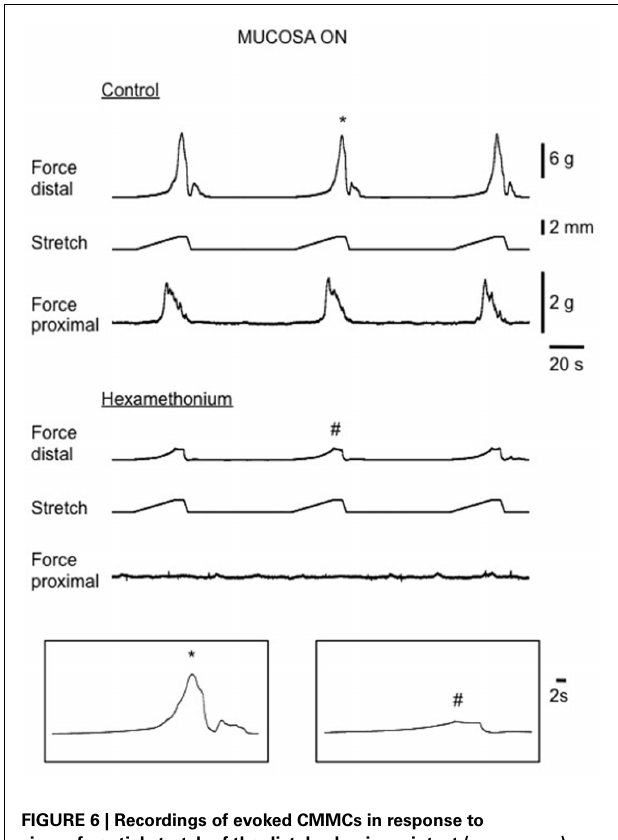
FIGURE 6 | Recordings of evoked CMMCs in response to circumferential stretch of the distal colon in an intact (mucosa on) control mouse colon. Top traces show passive and active increases in resting tension in the distal recording in response to graded stretch at a rate of 100 μ ms − 1 . In the bottom traces, hexamethonium abolished evoked CMMCs in the proximal colon whilst small passive increases in tension were recorded in the distal colon, where the stretch was applied.